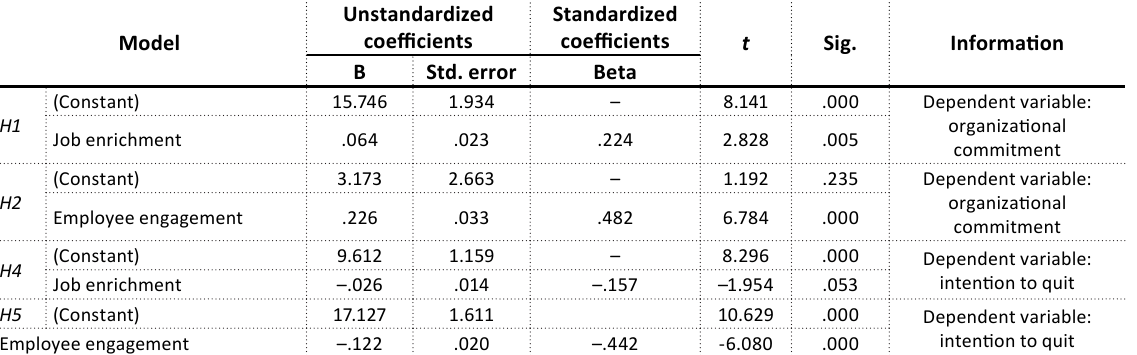
Table 1. Hypotheses test results Model